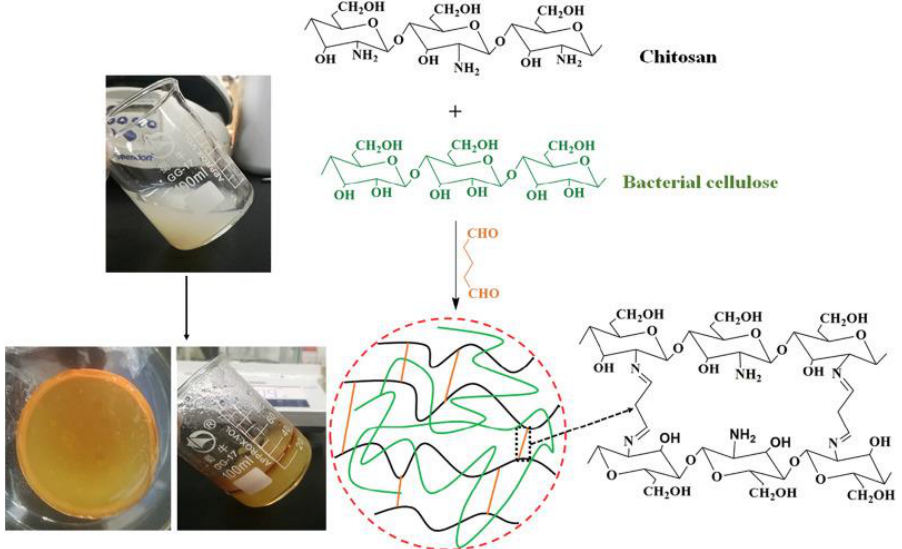
Figure 3. Fabrication process of semi-IPN hydrogel synthesis. Reprinted with permission from Reference [138]. Table 3. BC-based biomaterials fabricated and applied for wound-healing